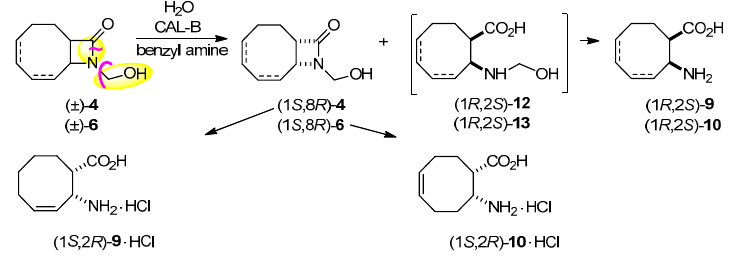
Table 2. CAL-B-catalyzed ring cleavage of racemic 3 a , 4 b , 5 a and 6 b .